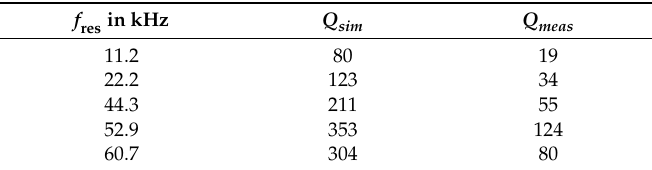
Table 2. Resonance Q factors of measurement and Table 2. Resonance 𝑄 factors of measurement and simulation.